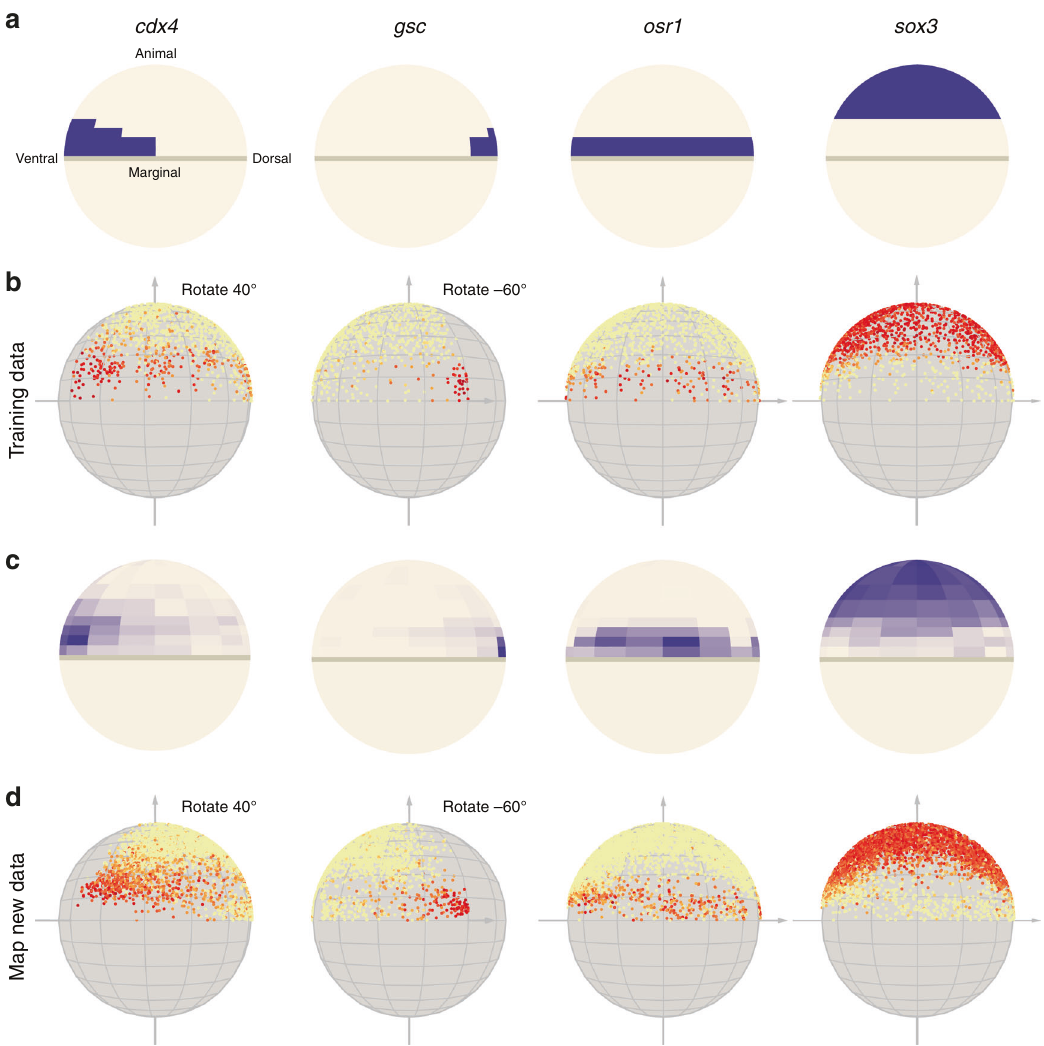
Fig. 5 Spatial mapping with scPhere. Representative marker gene expression from zebra fi sh in 50% epiboly on quarter spheres ( a , c ) and scPhere inferred spatial locations colored by marker gene expression ( b , d ) for the original marker expression ( a ) inferred expression after mapping cells to quarter spheres ( c ), and for 1406 cells in the training set ( b ) or another 3820 cells from three test batches ( d